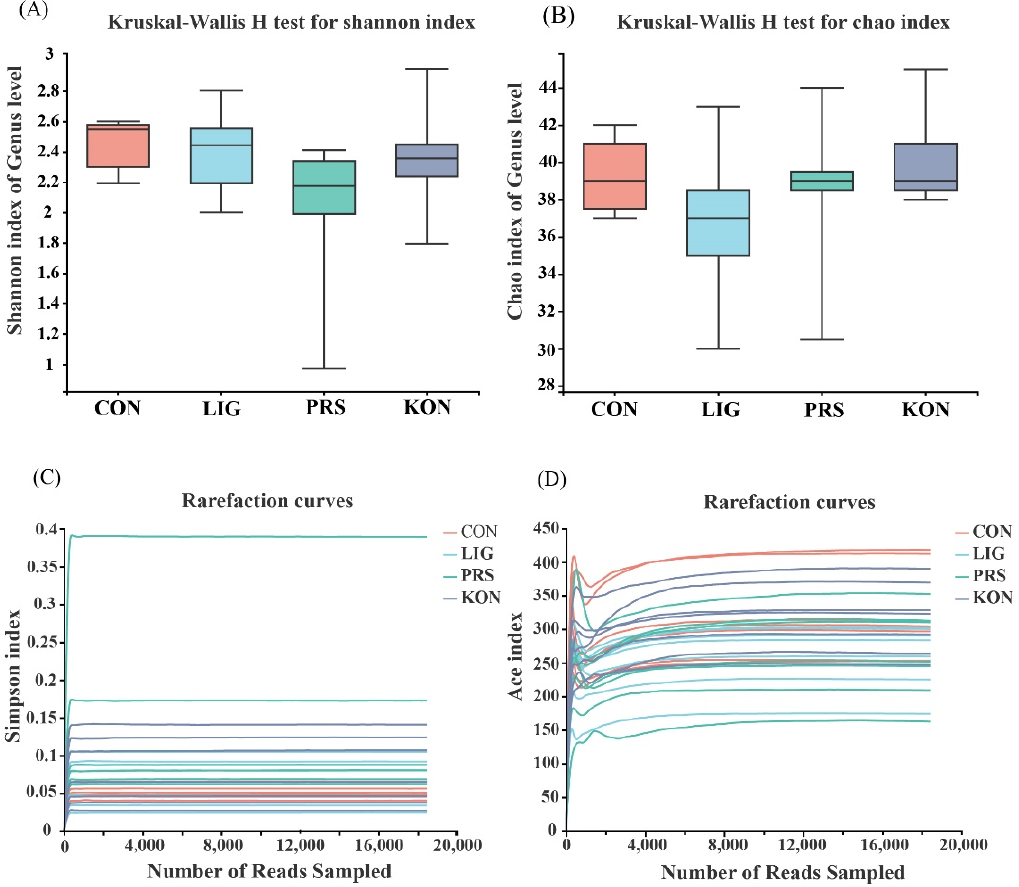
Figure 3. Microbial diversity in sow feces is affected by dietary fiber sources ( n = 7). Shannon ( A ), Chao ( B ), Simpson ( C ), and Ace ( D ) indicies. CON, control; LIG, lignocellulose; PRS, resistant starch; KON, konjaku flour.